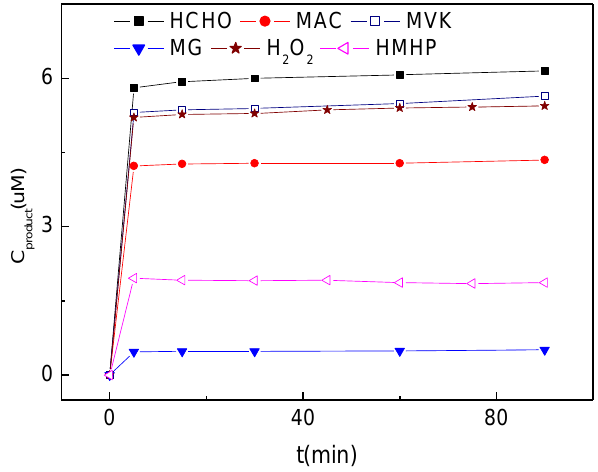
Fig. 1. The temporal profiles of the products in the aqueous iso- prene ozonolysis. T = 4 ◦ C, pH = 7.0, initial concentration ratio of = 2 : isoprene versus O 3 , C ISO : C O 3